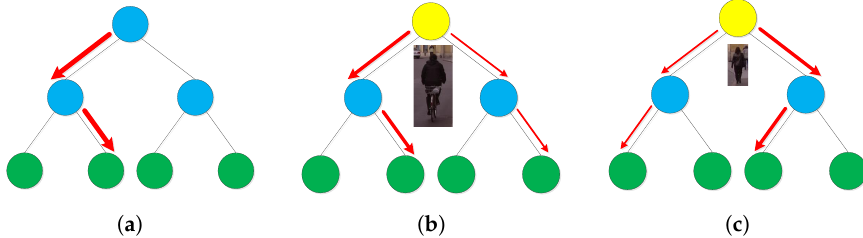
Figure 5. Comparison between hard decision trees and soft decision trees. The blue, yellow and green nodes denote hard decision node, soft decision node and leaf nodes respectively. The red arrows denote the flow of sample weights. ( a ) The hard decision tree is composed of hard decision nodes and leaf nodes. For a given sample, the hard decision node direct all its weight to one of its children; ( b ) The root node of the soft decision tree is a soft decision node which directs the sample weight to both its children according to the sample size. Given a large sample, the soft decision node directs more weight to its left branch. Note the arrow of the left branch is thicker than the arrow of the right branch; ( c ) Another example of the soft decision tree with a small sample. The soft decision node directs more weight to its right